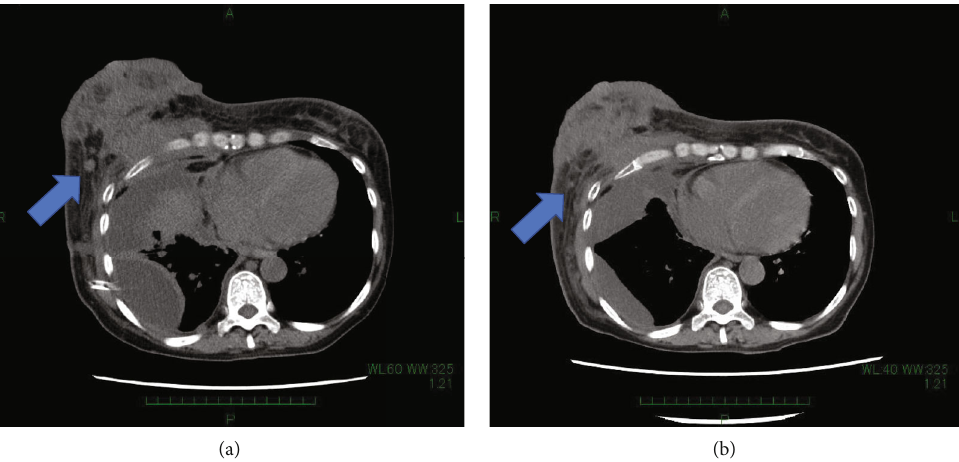
Figure 3: (a) Breast sections of CT scan before initiation of dabrafenib and trametinib. (b) Same section 2 weeks after treatment initiation. The arrow points to reduced mass and decreased pleural e ff usion.